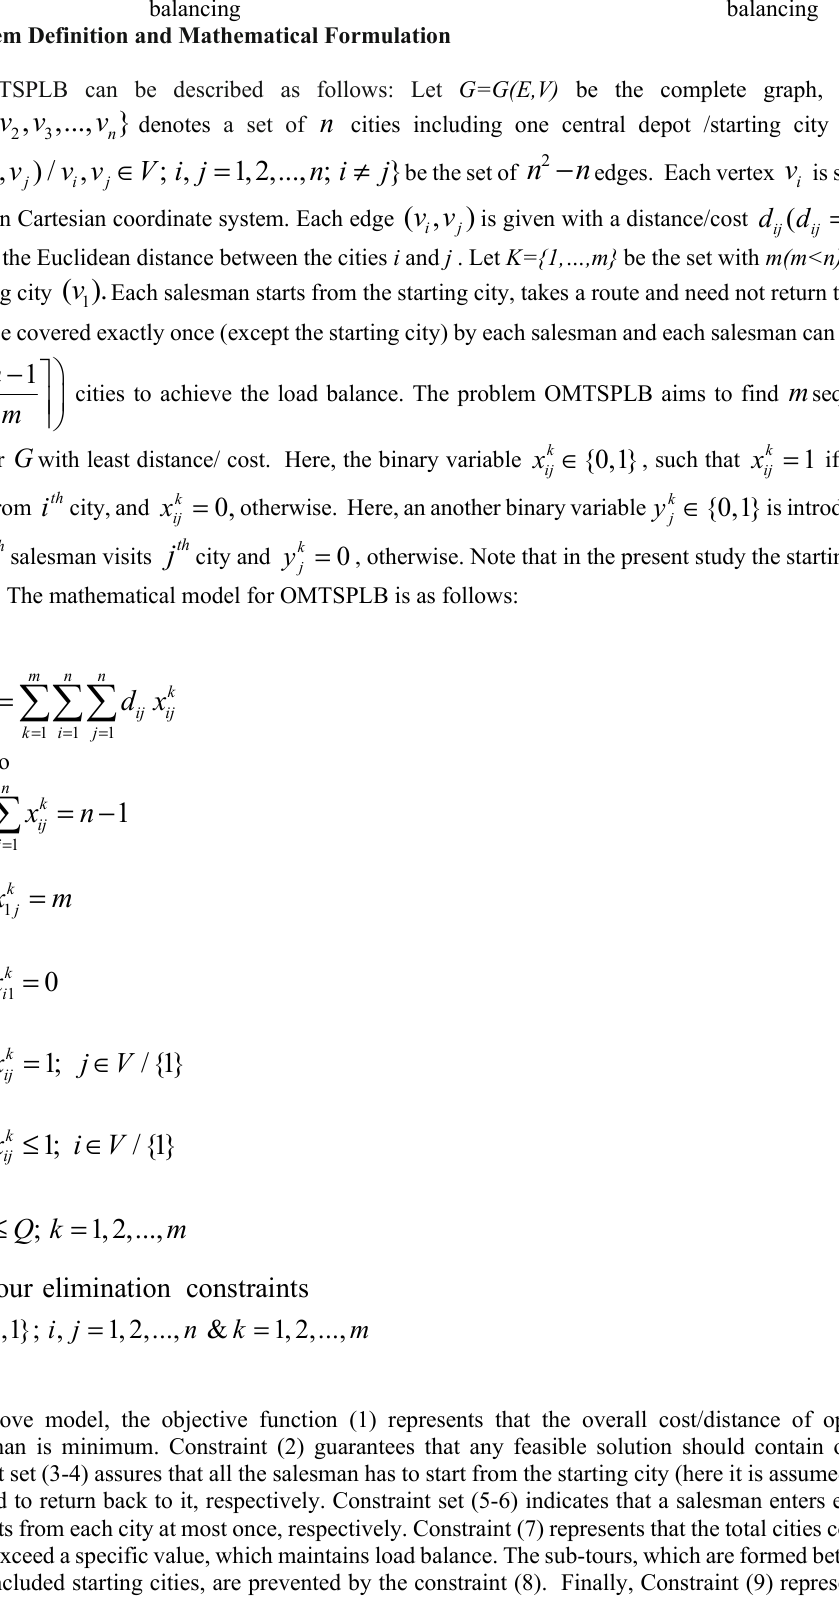
Fig 1. An example solution of OMTSP without load balancing